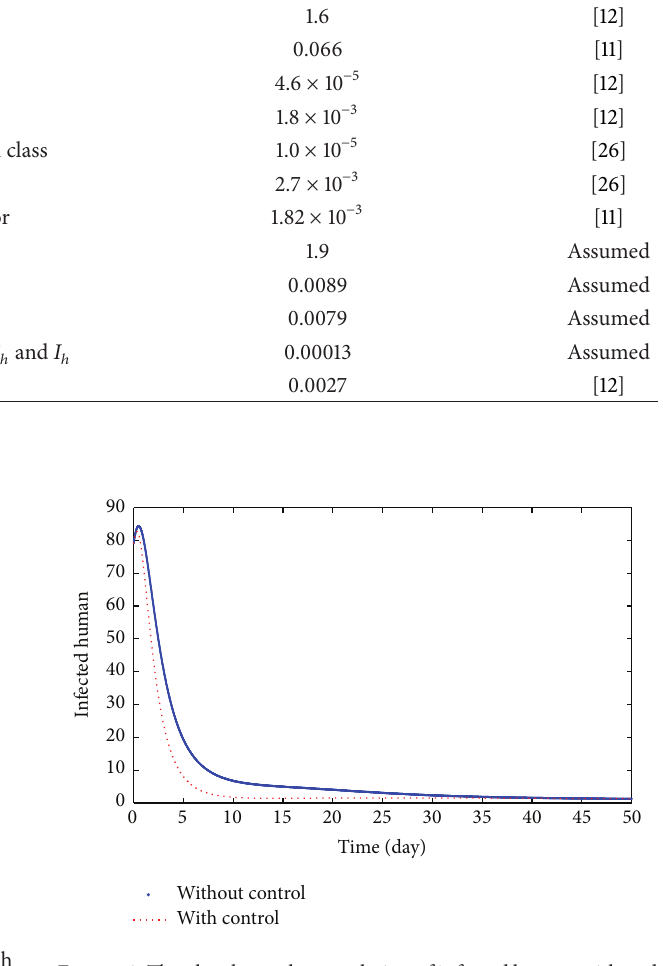
Figure3: Theplotshowsthepopulationofinfectedhumanwithand without control.